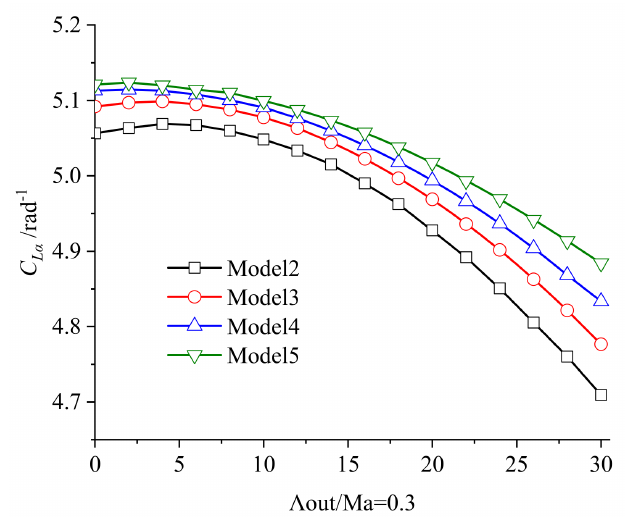
Figure 9. The variation in the lift line slope of the pre-selected models when AOA = 0 ◦ and Ma =